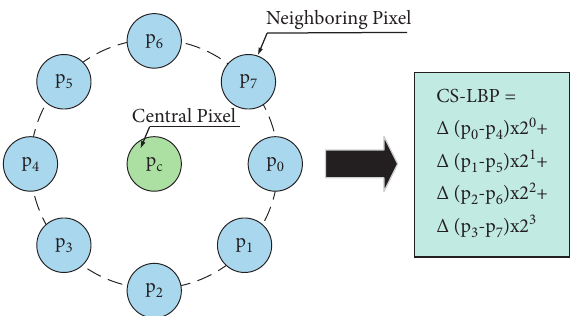
Figure 3: Demonstration of the CS-LBP texture